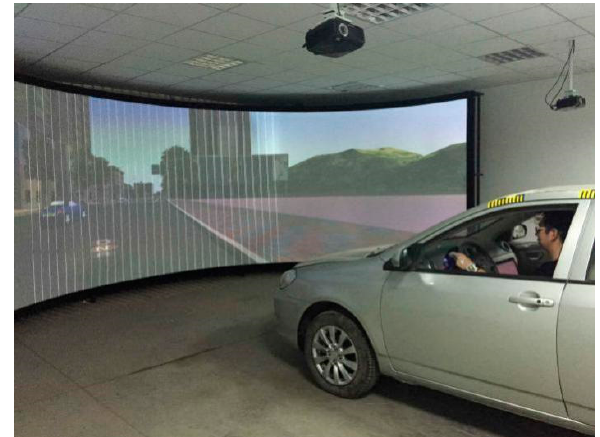
Figure 4. SCANeR simulation training system.